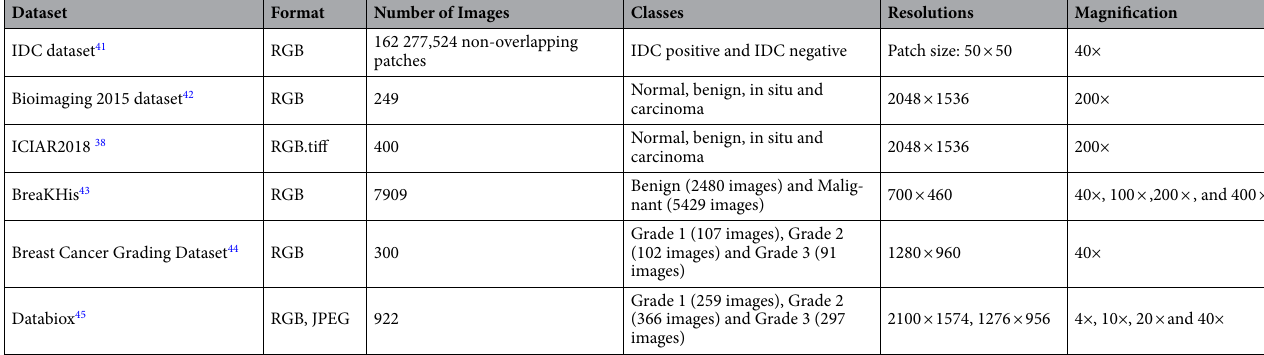
Table 2. This table summarises available databases of breast cancer histological